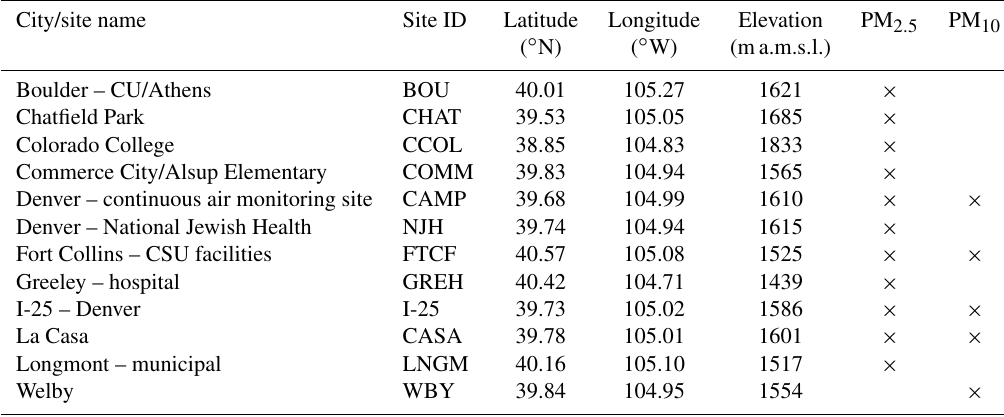
Table 1. CDPHE sites used for particulate data within the Colorado Front Range. Each site has an “ × ” for each measurement it maintained throughout the current work. Elevation is provided in meters above mean sea level